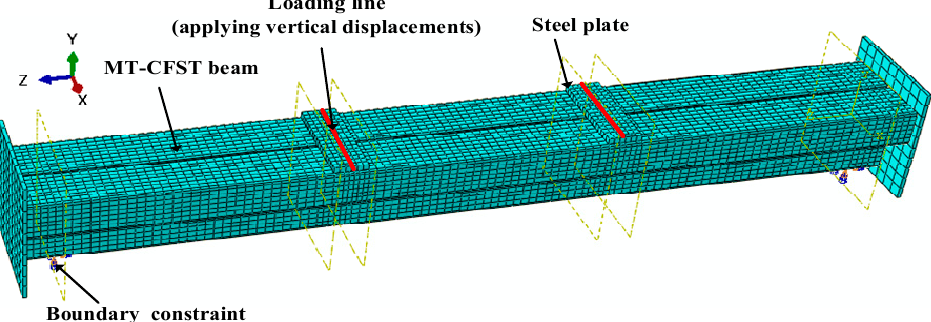
Figure 12. A typical FE model for MT-CFST beam. The stress–strain relationship of steel tube was modelled based on the five-stage (elastic, elastic–plastic, plastic, hardening and fracture) curve suggested by Han et al. [34]. The Von Mises yield criterion in conjunction with plastic flow rules were used in multi-axial stress states. Young’s modulus and the Poisson’s ratio were taken as 2 × 10 5 MPa and 0.3, respectively. The adopted stress–strain curve for steel tubes is given by E ε s ε s ≤ ε p ( 24 ) σ s = f u ε u < ε s ( 28 ) where σ s and ε s are the stress and strain of steel, respectively; E , f p , f y and f u are Young’s modulus, proportional limit, yield strength and ultimate strength of the steel, respectively; ε p = 0.8 f y / E ; ε y = 1.5 ε p ; ε uy = 10 ε y ; ε u = 100 ε y ; A = 0.2 f y /( ε y − ε p ) 2 ; B = 2 A ε y ; C = 0.8 f y + A ε p